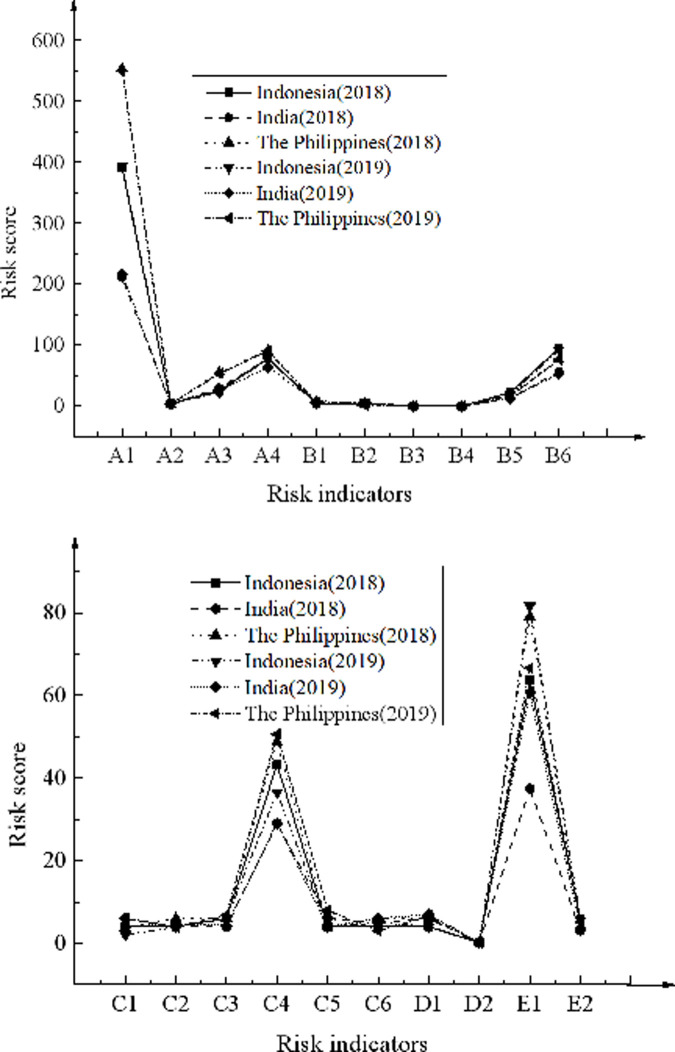
The results of the overseas investment risk assessment of Asian country clusters in 2018–2019.(a) Risk categories of basic resources and economic and finance; (b) Risk categories of political systems, environmental protection, and resources and energy.